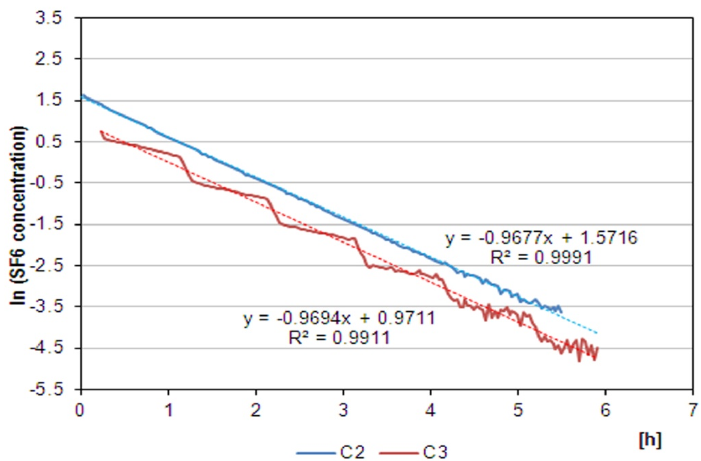
Figure 5. Flow rate per hour.